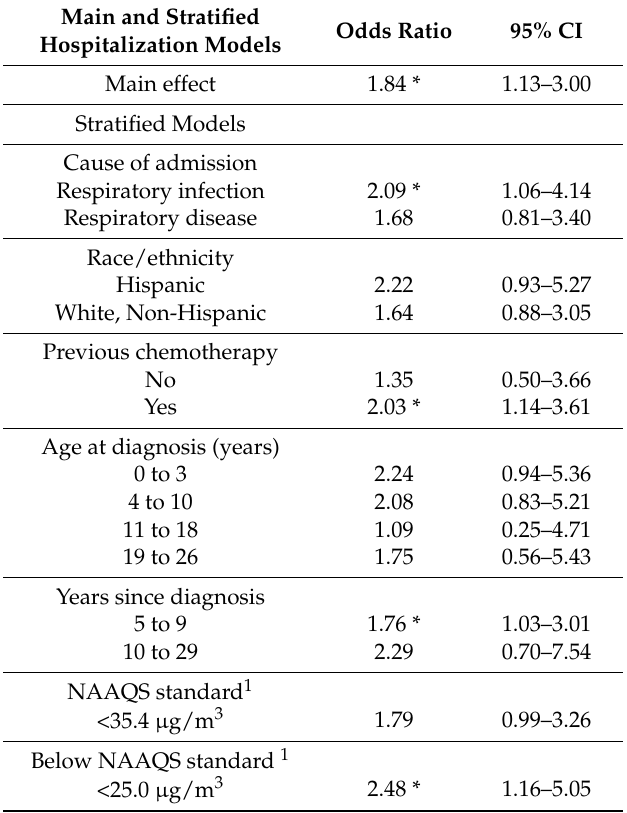
Table 3. Odds ratios and 95% confidence intervals (CI) for the main and stratified effects of a 10 µ g/m 3 increase in PM 2.5 with respiratory hospitalizations among survivors of childhood